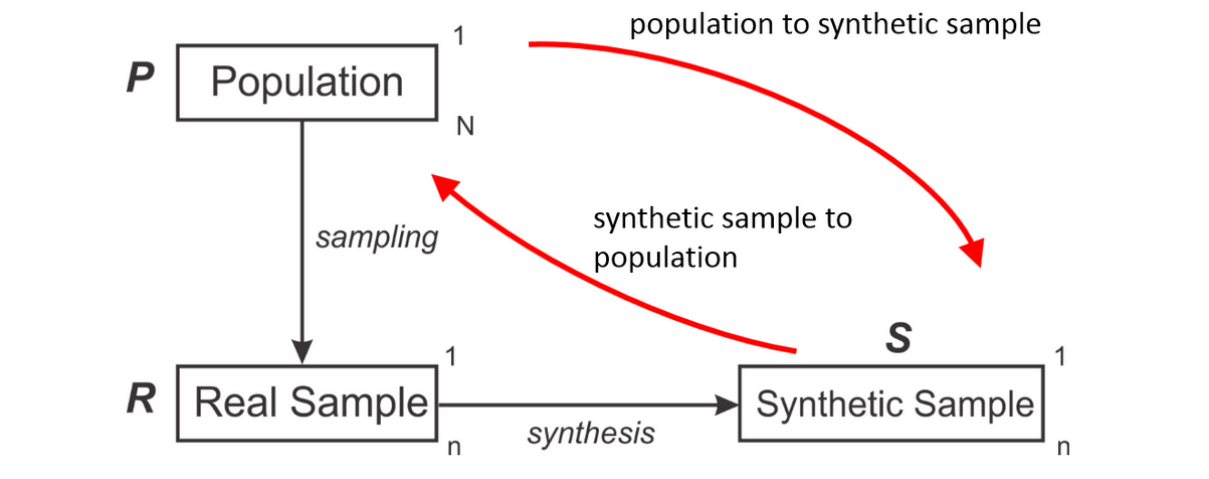
Figure 1. The relationships between the different datasets under consideration. Matching between a synthetic sample record and someone in the population goes through the real sample and can occur in 2